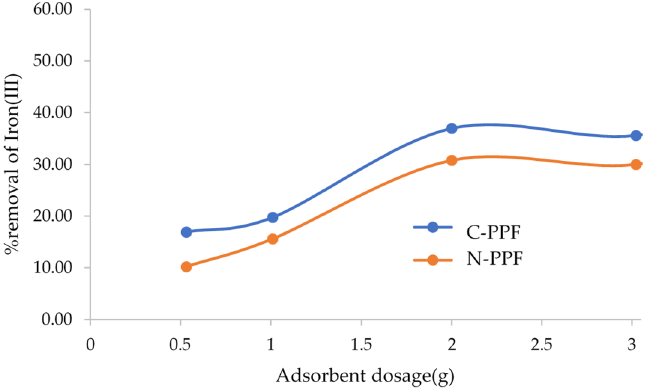
Figure 4. Variation in percentages of Fe(III) removal with adsorbent dosages (at concentration of Fe(III) is 4 mg/L, pH4, 30 °C and 300 min).